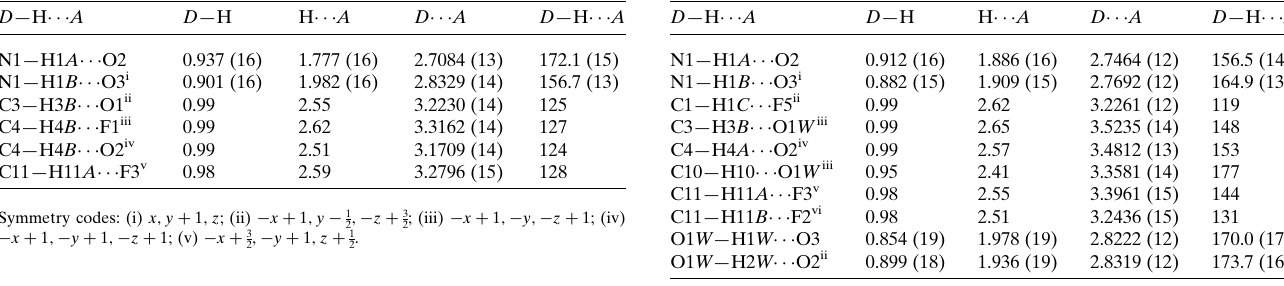
Table 1 Hydrogen-bond geometry (A˚ , (cid:5) ) for I .